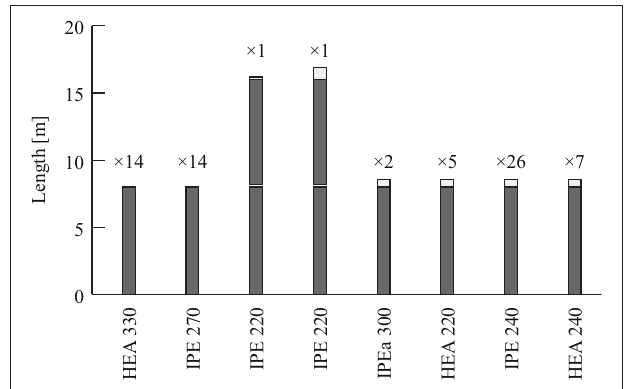
FIGURE 9 | Stock utilization for secondary